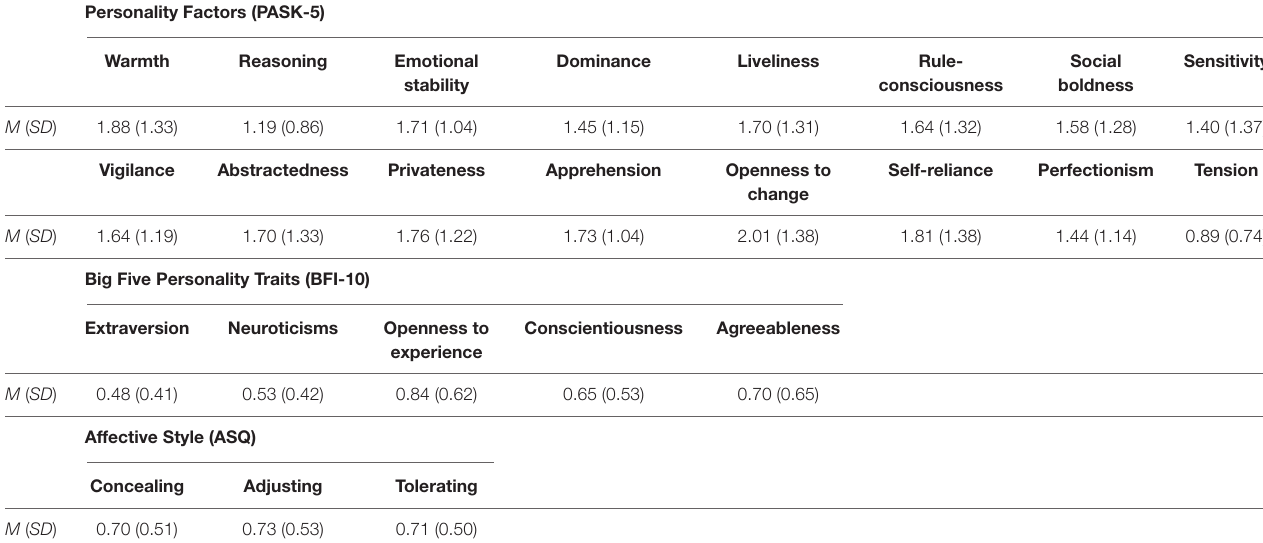
TABLE 4 | Intra-team differences of personality and emotion regulation for elite beach volleyball teams ( N = 40). Personality Factors